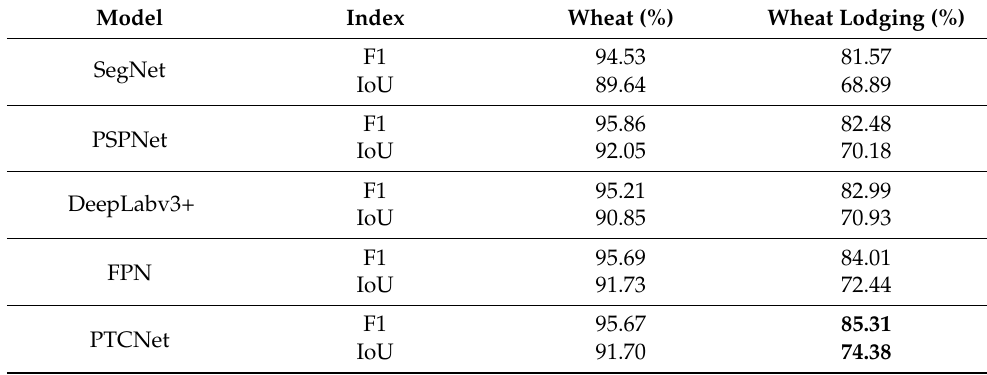
Table 7. Segmentation results in comparison of different networks on the test dataset.